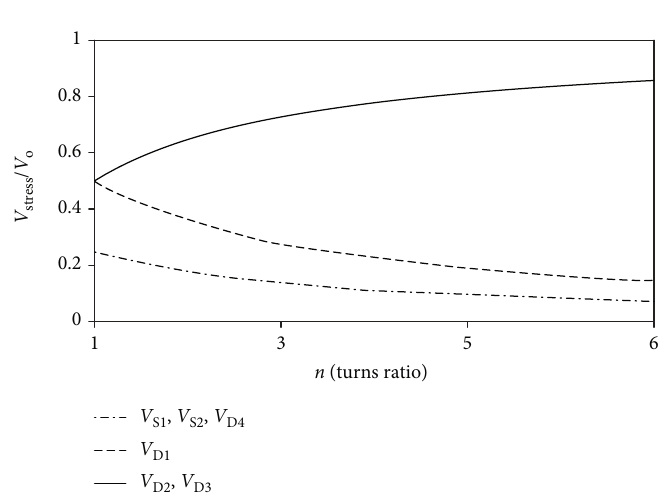
Figure 6: Normalized semiconductor voltage stress versus turn ratios.